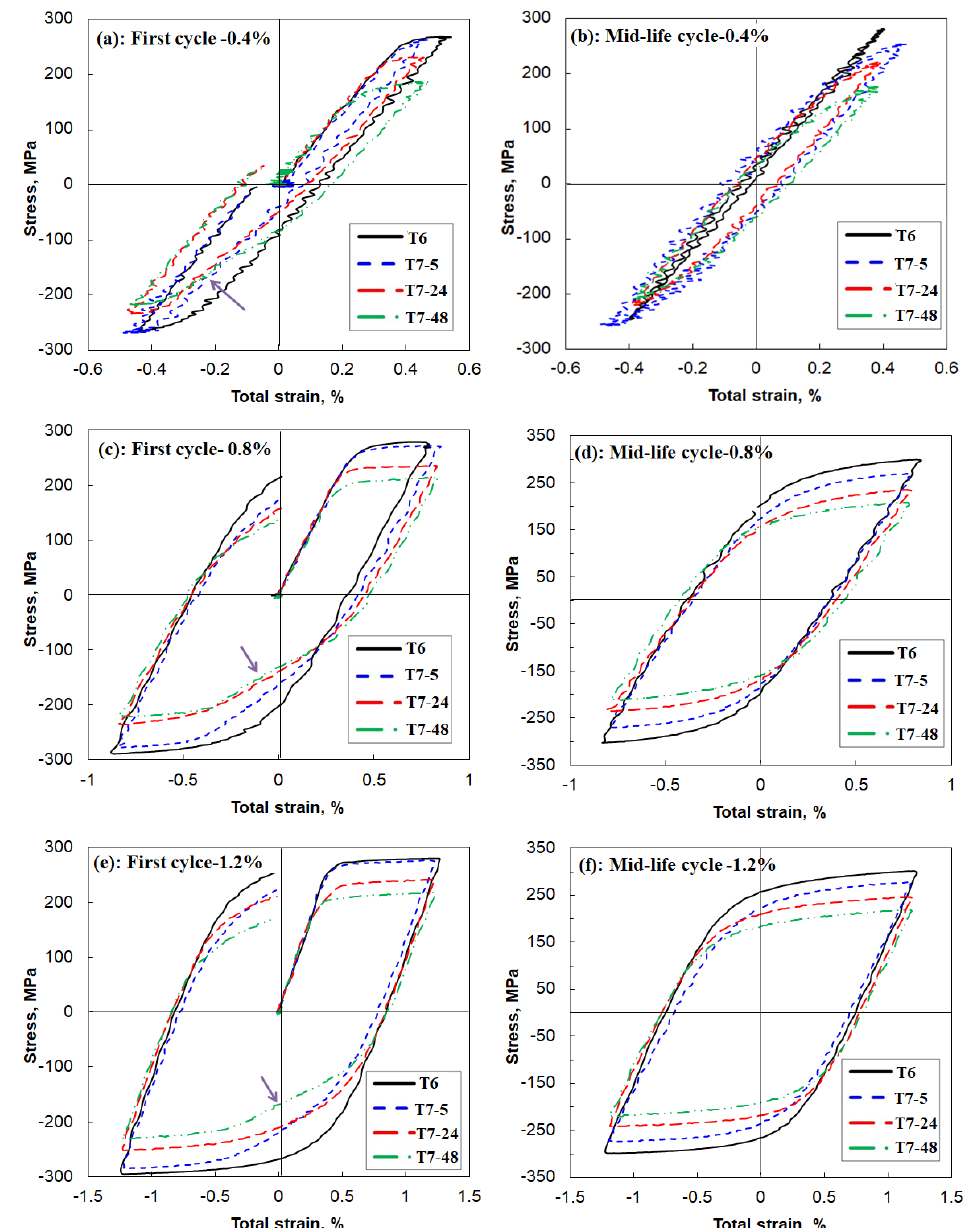
Figure 5. First and mid-life cycle hysteresis loops under various aging conditions at given strain amplitudes of ( a , b ) 0.4%, ( c , d ) 0.8%, and ( e , f ) 1.2%. Secondly, the maximum/minimum peak stresses decreased with increasing T7 aging time at all strain amplitudes. In the first cycle, the maximum/minimum peak stresses were similar between T6 and T7-5 to those between the T7-24 and T7-48 conditions, but they decreased from T6/T7-5 to T7-24/T7-48, which was similar to the evolution of the monotonic mechanical properties (Table 2). In the mid-life cycle, the difference in peak stresses between each aging condition became larger, indicating the varying cyclic stress and strain response under various aging conditions. Table 3 lists the differences in peak stresses and plastic strain between T6 and various T7 conditions during the first and mid-life cycles. It was also noted that the plastic strain generally increased with increasing